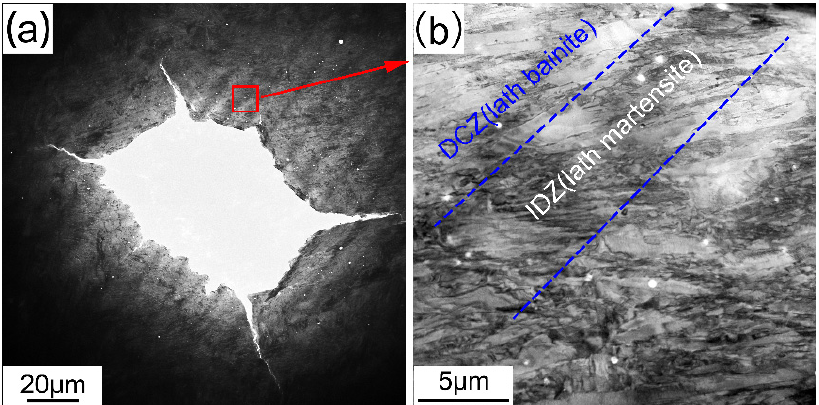
Figure 3. The microstructure in dendrite core zone (DCZ) and IDZ of Ni5.5 analyzed by TEM; ( b ) is the local magnification of ( a ).